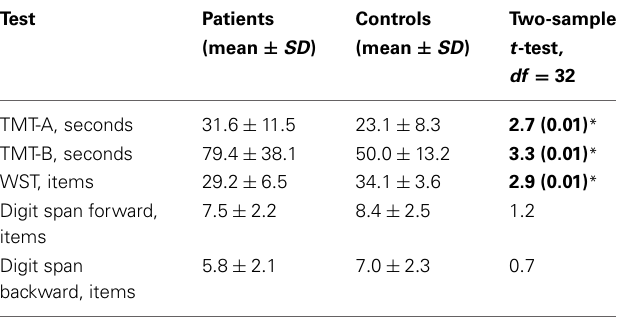
Table 2 | Neuropsychological assessment and comparison of healthy participants and patients with